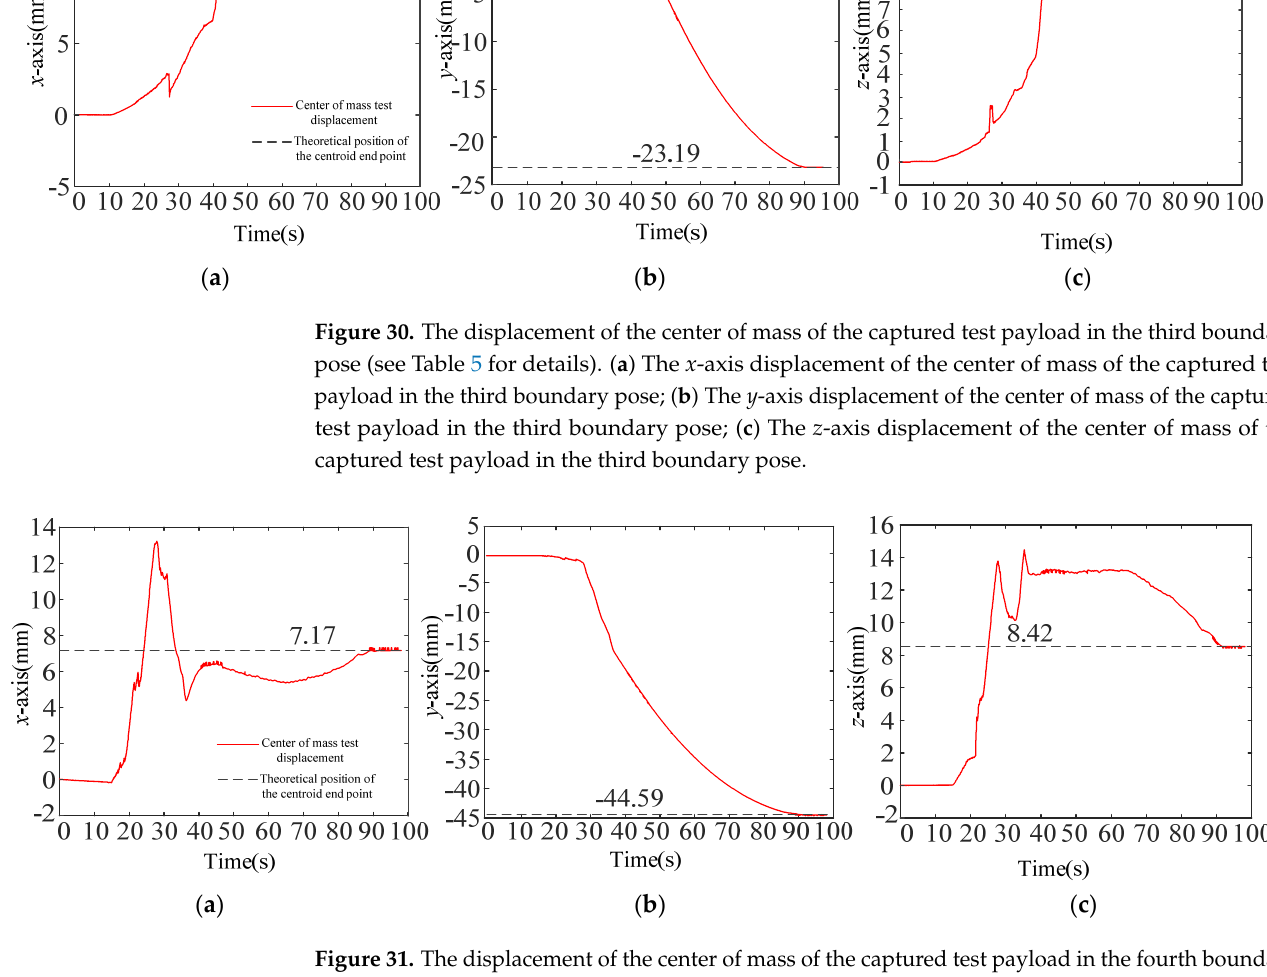
Figure 31. The displacement of the center of mass of the captured test payload in the fourth boundary pose (see Table 5 for details). ( a ) The x -axis displacement of the center of mass of the captured test payload in the fourth boundary pose; ( b ) The y -axis displacement of the center of mass of the captured test payload in the fourth boundary pose; ( c ) The z -axis displacement of the center of mass of the captured test payload in the fourth boundary pose.